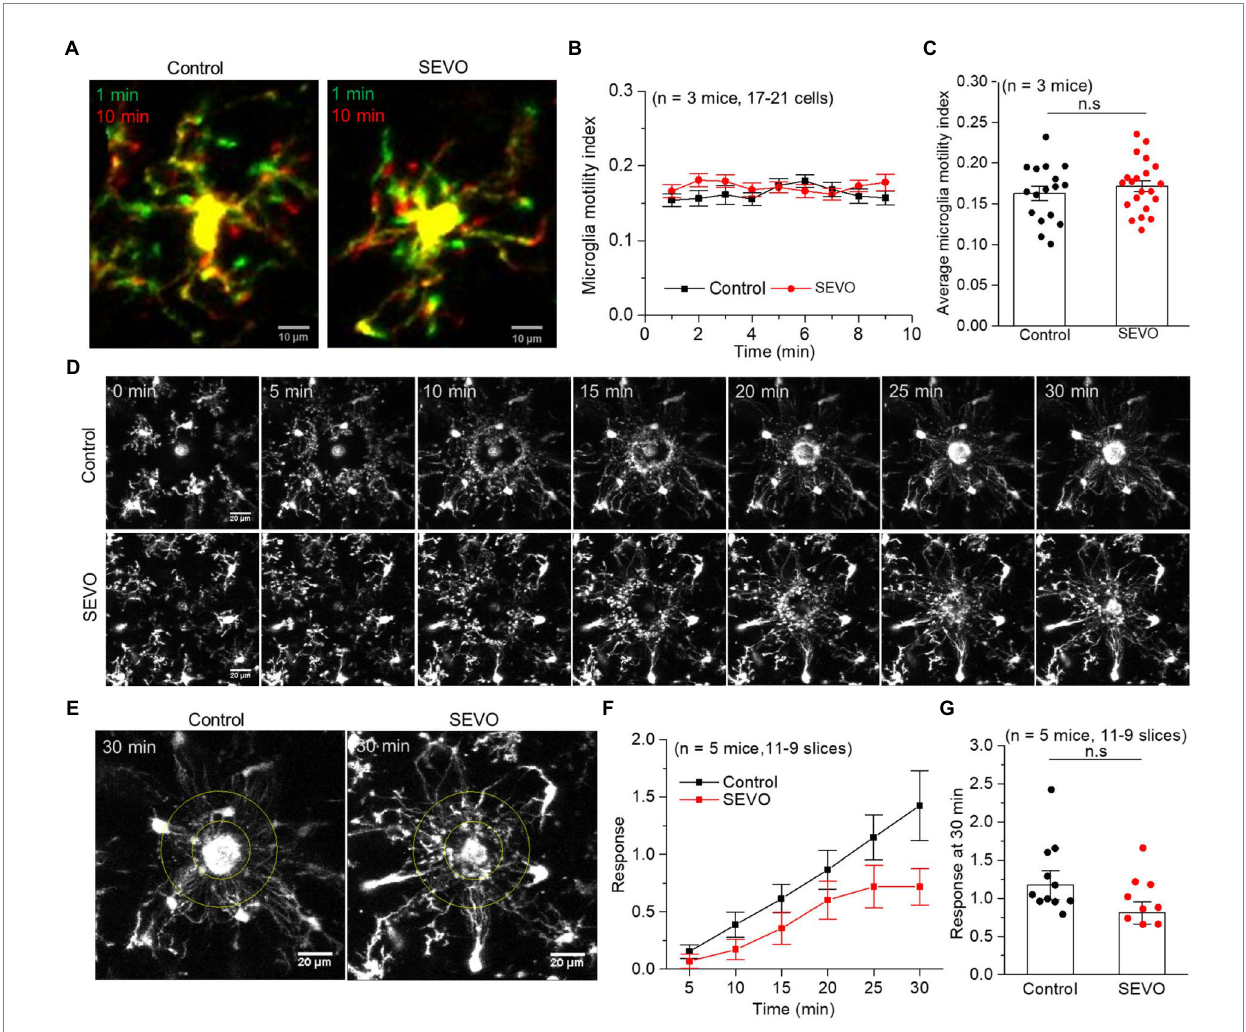
FIGURE 4 Microglia surveillance capability in resting and stimulated states 7 days after prolonged neonatal sevoflurane exposure. (A) Representative images of microglia in acute brain slices of CX3CR1-EGFP mice during 10-min imaging in the resting state 7 days after prolonged sevoflurane exposure. Green represents microglia at 1 min, red represents microglia at 10 min, and yellow represents the part without morphological change at 10 min compared to 1 min. (B) Microglia motility index analysis during 10 min imaging in the resting state. (C) Quantification of average microglia motility index during 10 min imaging in the resting state ( p = 0.434, two-sample t -test). (D) Representative images of microglia response to laser burn injury within 30 min in acute brain slices of CX3CR1-EGFP mice 7 days after prolonged sevoflurane exposure. (E) Representative images of microglia in acute brain slices of CX3CR1- EGFP mice at 30 min after laser burn injury. (F) Response index of microglia within 30 min after laser burn injury of acute brain slices of CX3CR1-EGFP mice. (G) Quantification of response index of microglia at 30 min after laser burn injury of acute brain slices of CX3CR1-EGFP mice ( p = 0.067, two- sample t -test). Data are shown as mean ±